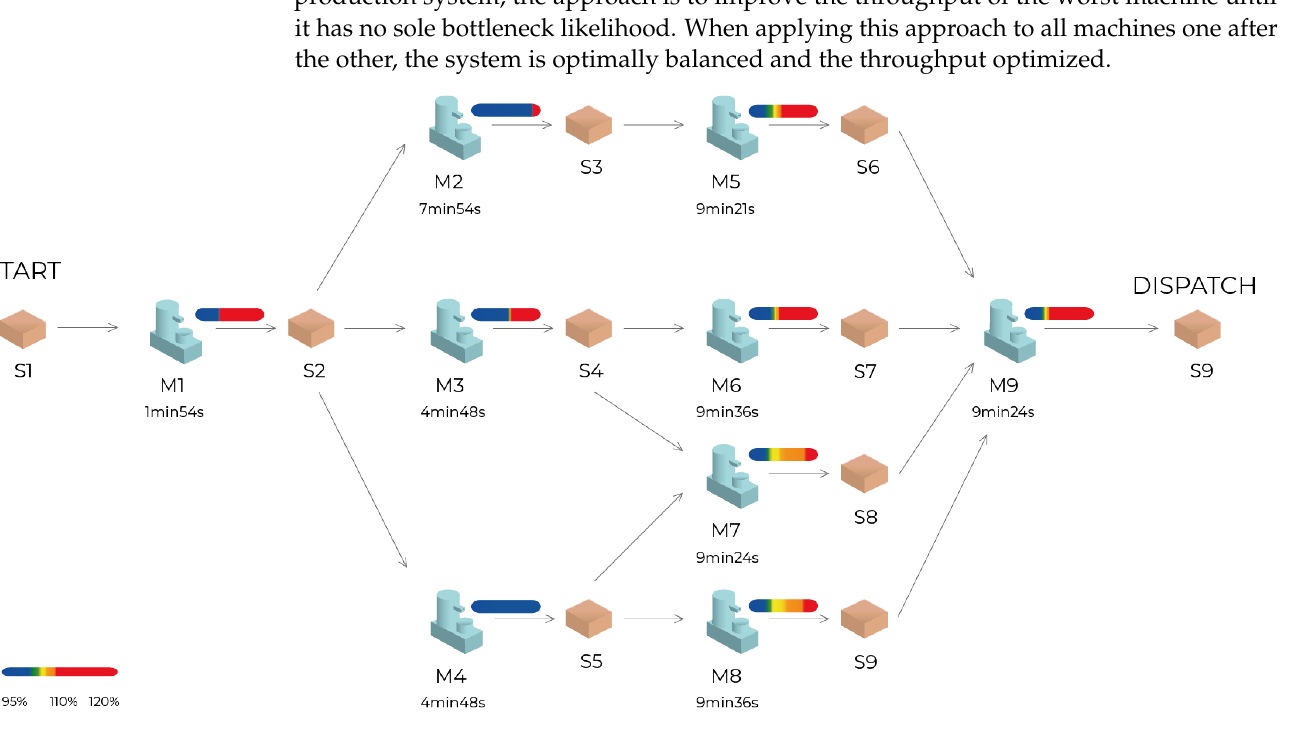
Figure 9. Scheme of a possible visualization of the process